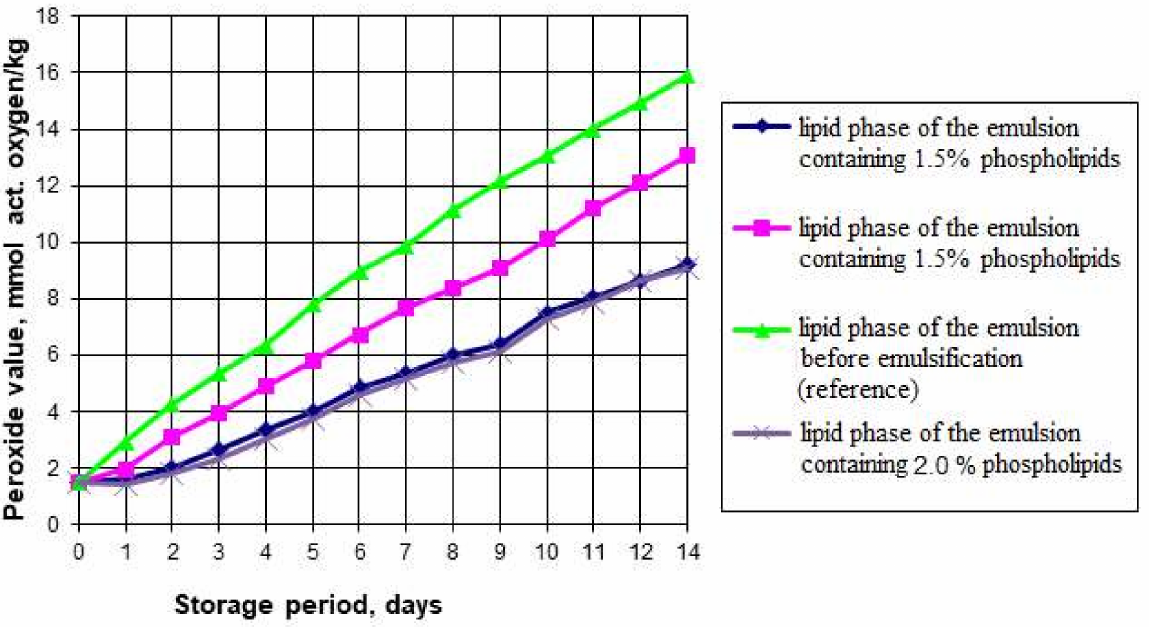
Figure 1. Peroxide number in the phospholipid emulsions during accelerated